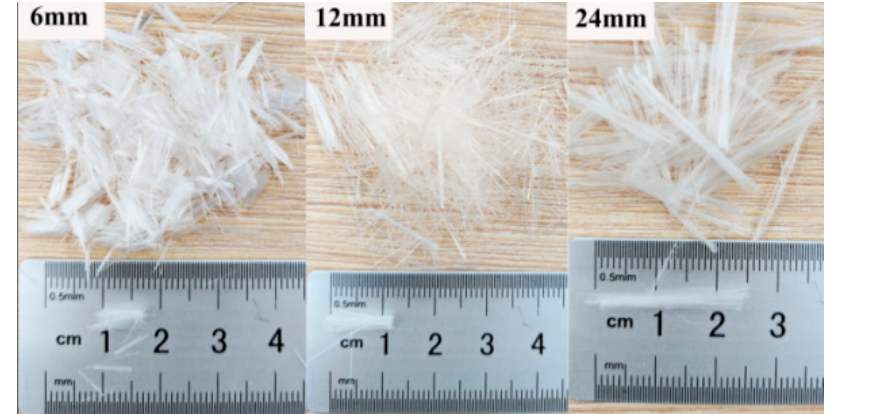
Figure 2. Polypropylene (PP) fiber used for the reinforcement. Table 3. Mechanical properties of polypropylene (PP)